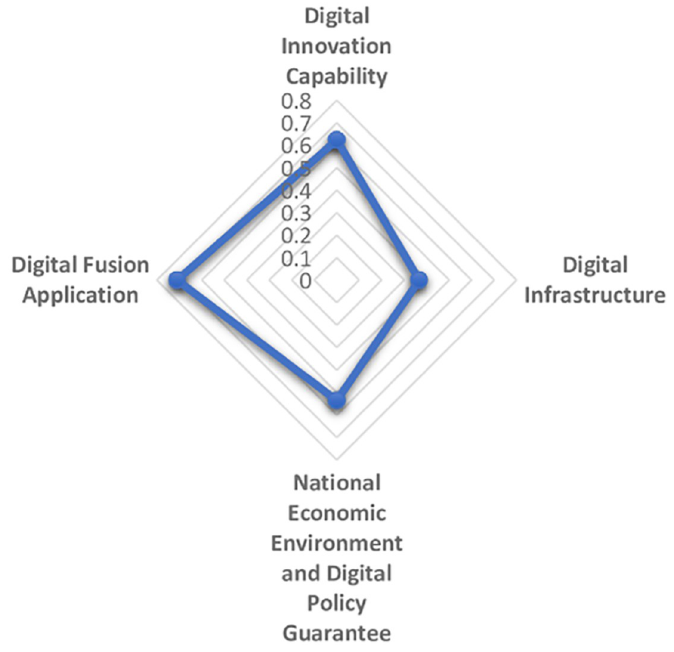
Fig 8. Radar map of northeast digital economy development.